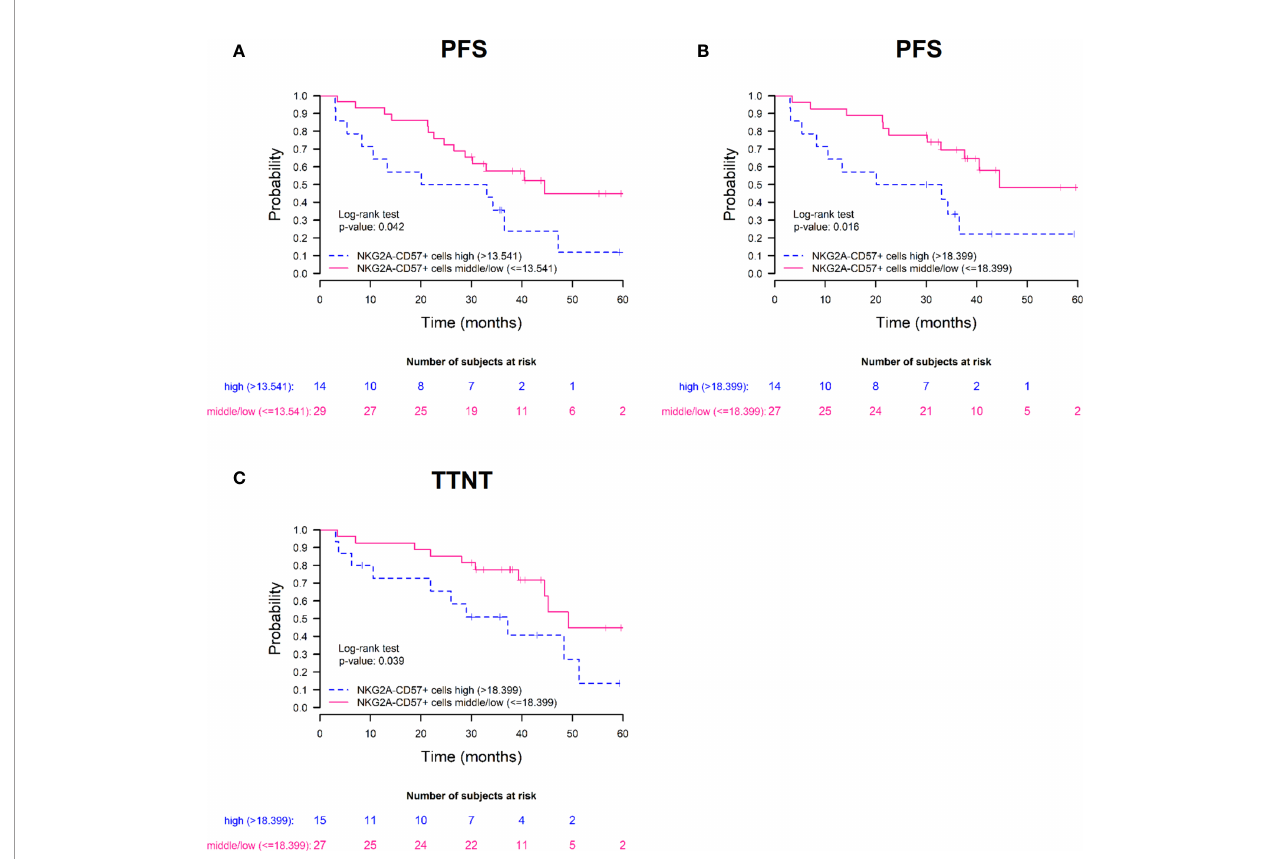
FIGURE 5 | High frequencies of terminally differentiated NKG2A-CD57+ NK cells associate with poor prognosis after autoHSCT in MM patients. Survival rates of progression-free survival (PFS) (A, B) and time to next treatment (TTNT) (C) in patients with multiple myeloma treated with autoHSCT. Patients are grouped based on the frequency of NKG2A-CD57+ NK cells on day 30 (A) and day 100 (B, C) after autoHSCT. Patients were grouped based on 66 th percentile: high group (>66 th percentile) and middle/low group ( ≤ 66 th